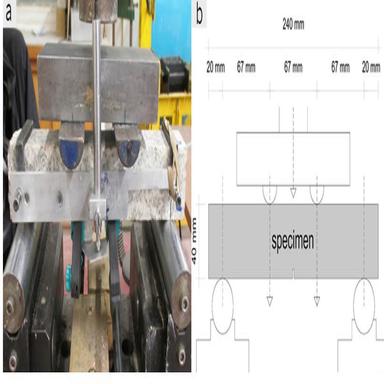
4-point bending test setup: (a) general view; (b) test setup.